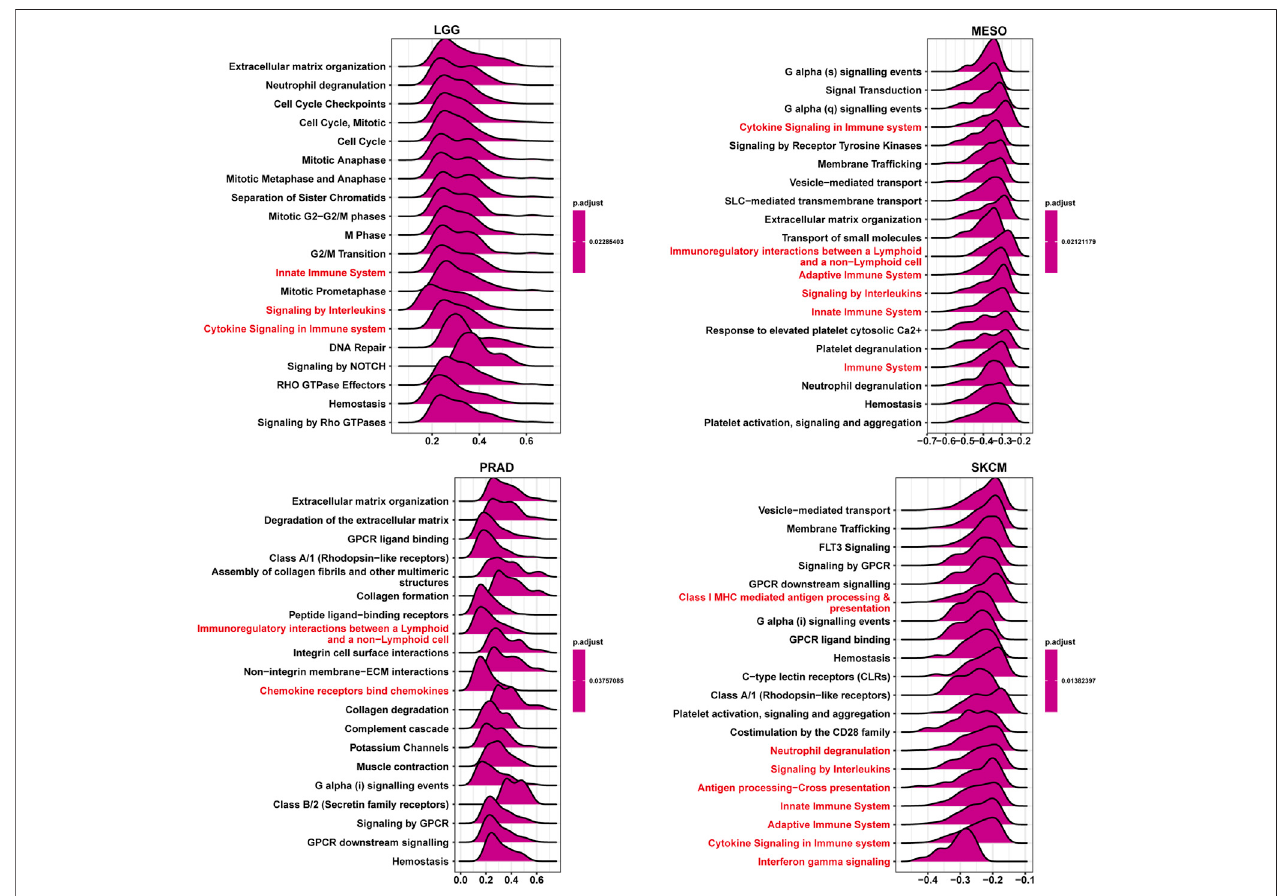
FIGURE 7 | GSEA of ISYNA1. The top 20 GSEA results were shown in indicated tumor types. Red represents immune-related pathways.